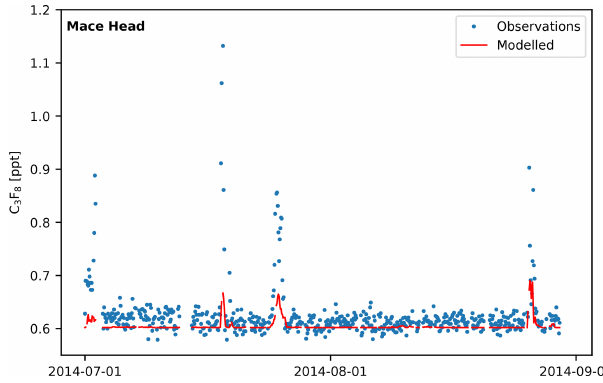
Figure 11. Comparison of measured (blue dots) and modelled (red line) C 3 F 8 mole fractions at MHD for July–August 2014. Dates are chosen for illustrative purposes